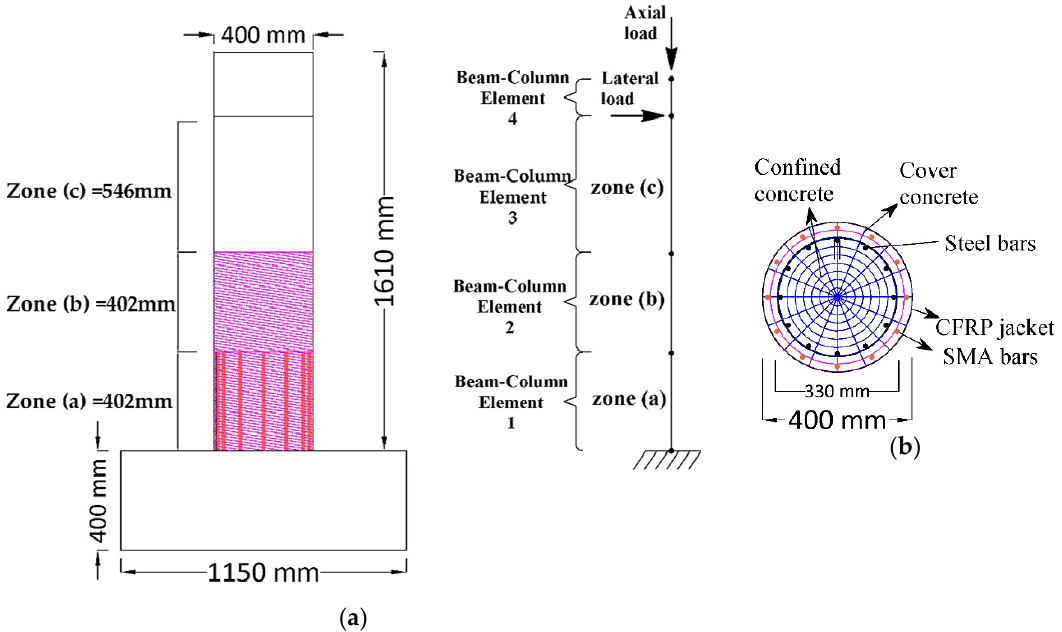
Figure 4. ( a ) Schematic of the column in Group1 and its numerical model; ( b ) fiber discretization of the retrofitted column in Group1.